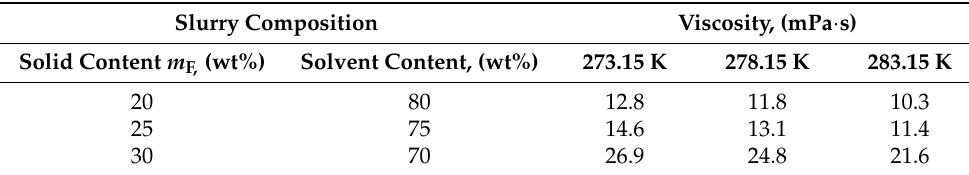
Table 1. Comparison of the viscosities of the slurries with different solid and the same solvent (ethylene glycol 20 wt% + water 80 wt%) contents at different temperatures and normal pressure. Slurry Composition Viscosity, (mPa · s) Solid Content m F, (wt%) Solvent Content, (wt%) 273.15 K